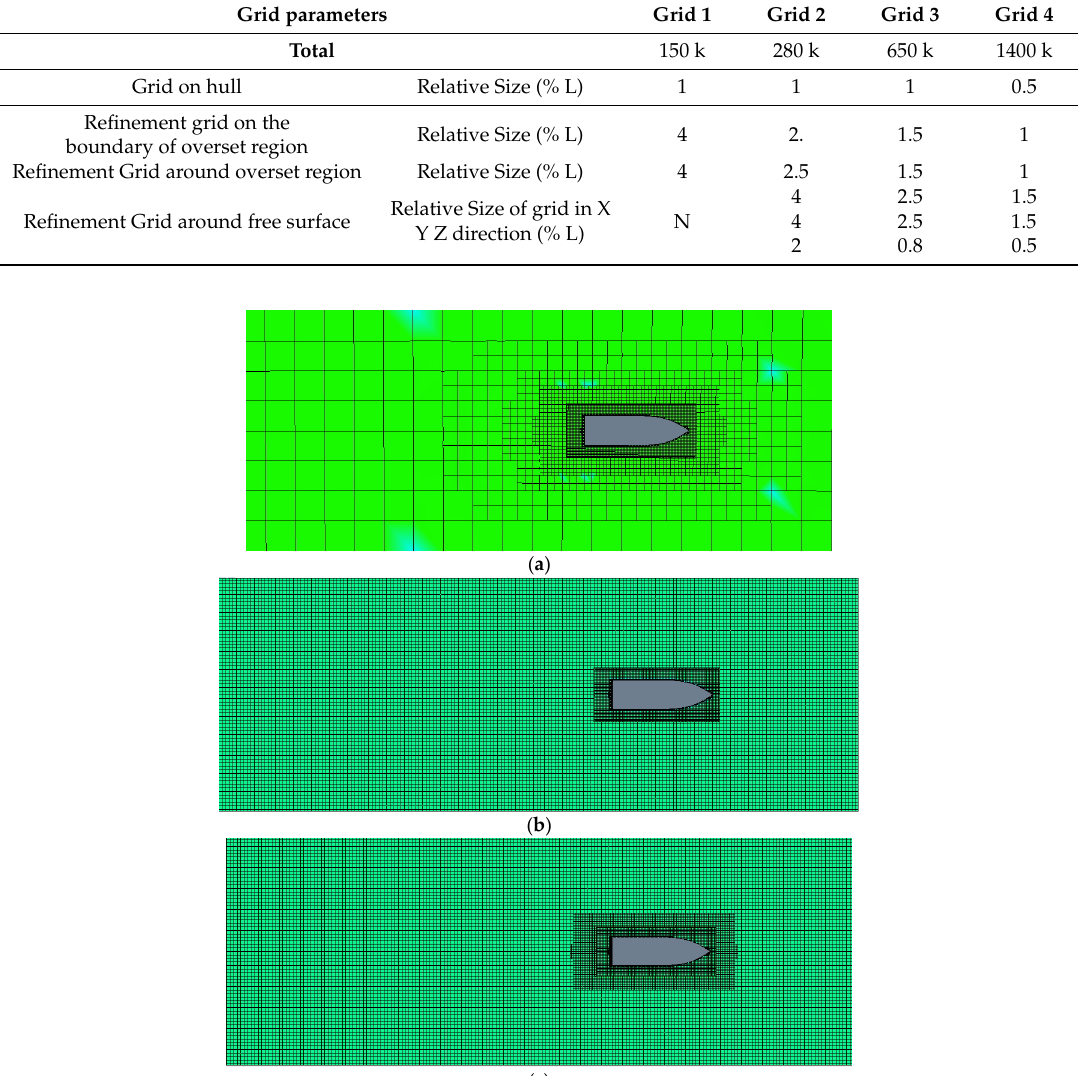
Table 4. Size of the grid.